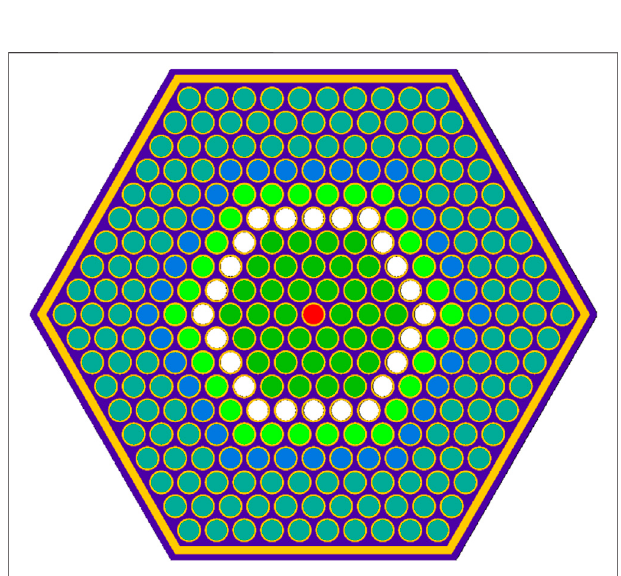
FIGURE 6 | Hexagonal assembly geometry modeling of SHARK.